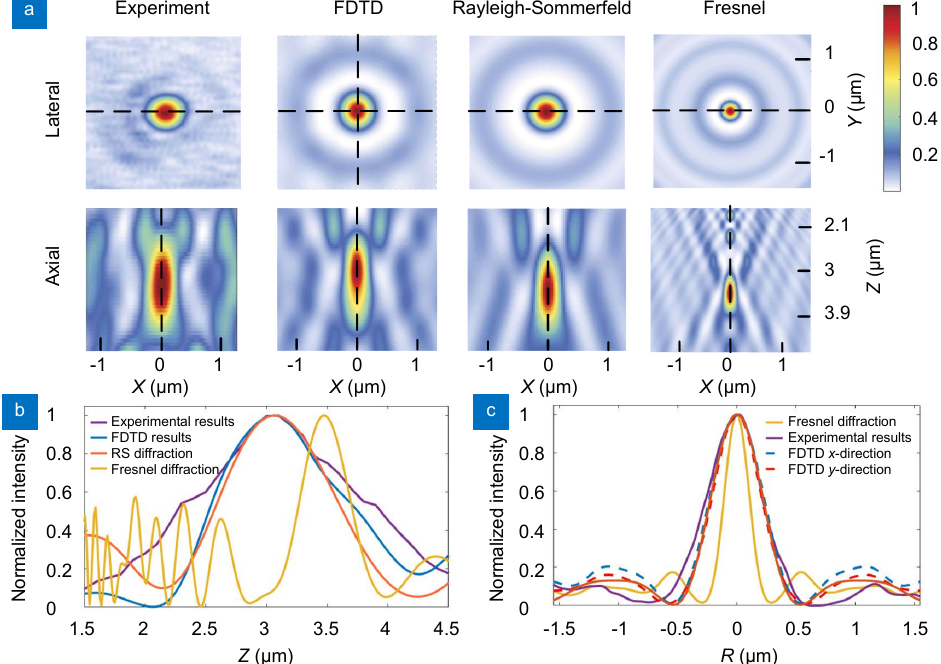
Fig. 4 | Intensity distributions of theoretical and experimental results of Lens 1 . ( a ) Intensity distributions in the lateral and axial planes. ( b ) Intensity distribution along the black dash lines in the axial planes. ( c ) Intensity distribution along the black dash lines parallel to the x axis in the lateral